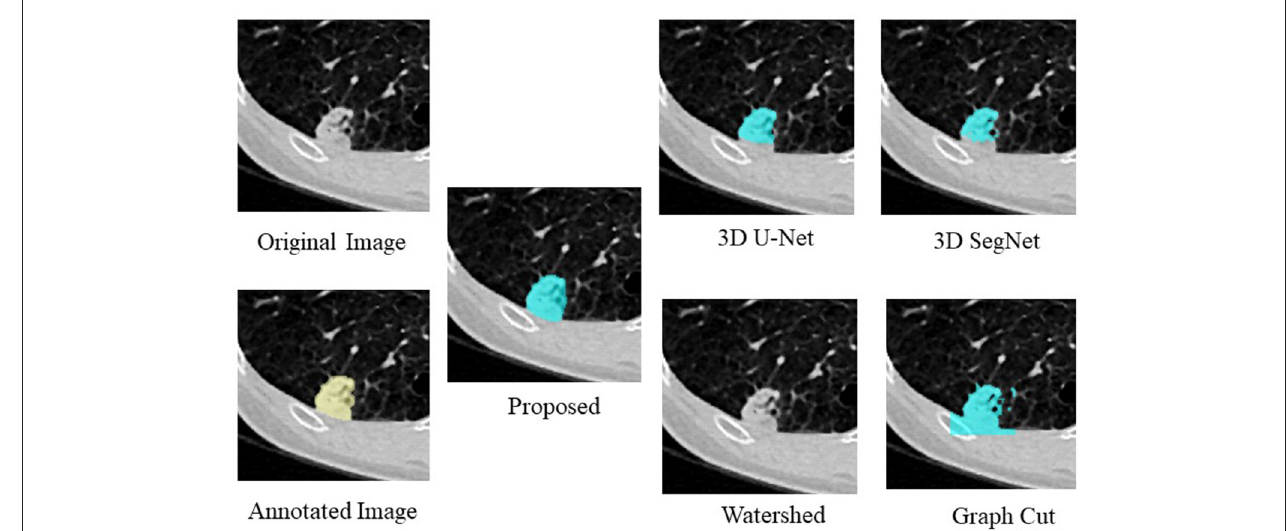
FIGURE 4 | Examples of segmentation results in the case of a nodule attached to the chest wall.